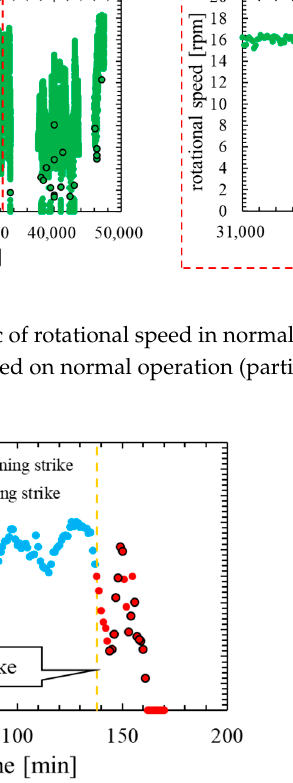
Figure 4. Time characteristic of rotational speed at the accident.